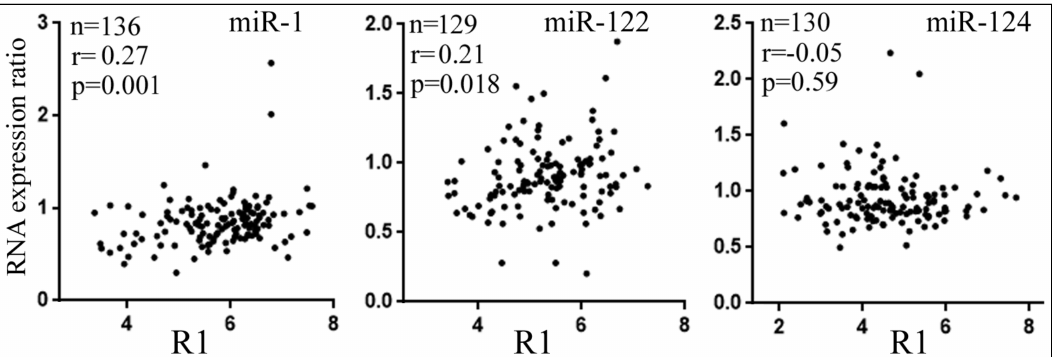
Figure 8. Correlations between R1 values and changes in target mRNA levels upon miRNA transfection in 293T cells. Y -axes show RNA levels under miRNA transfection condition divided by those under the control RNA transfection condition. Dots represent individual confirmed targets. The sample size ( n ), correlation coe ffi cients (r), and p -values are